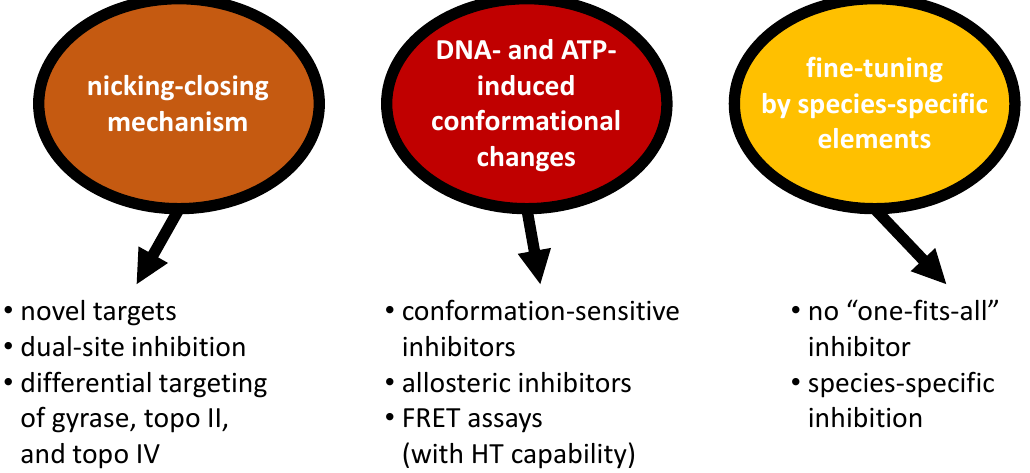
Figure 8. Novel strategies for gyrase inhibition and inhibitor identification. Insight into the mechanism of DNA supercoiling by gyrase opens up novel pathways for gyrase inhibition. See “Implications for gyrase inhibition: Conclusions and Outlook” for details and discussion. HT: high throughput, topo II/IV: topoisomerase